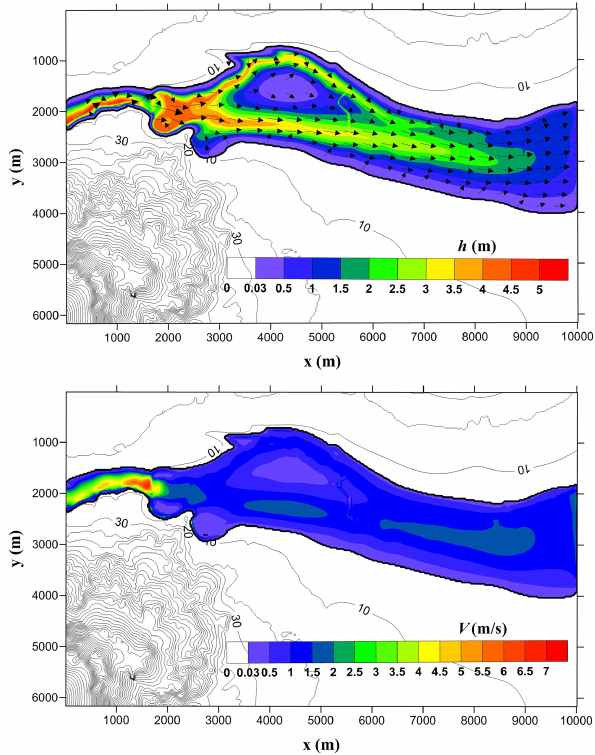
Figure 6. Snapshots from the application of FLOW-R2D in the es- tuary of Spercheios River with water depth and flow velocity, re- spectively.